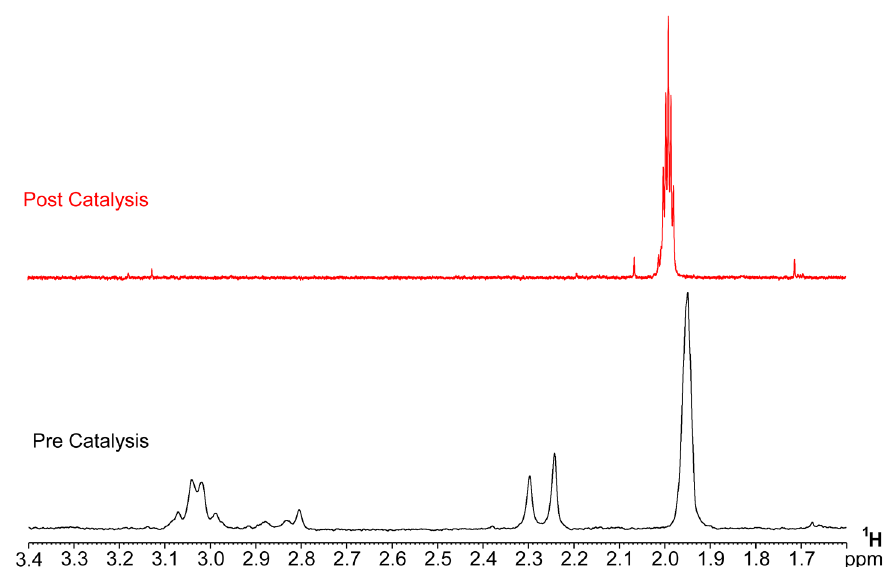
Figure 7. 1 H-NMR spectra (NaOD / D 2 O, 298K) before ( bottom ) and after ( up ) a catalytic run, showing the disappearance of the aliphatic resonance of the EDTA ligand at 2.2–3.2 ppm.